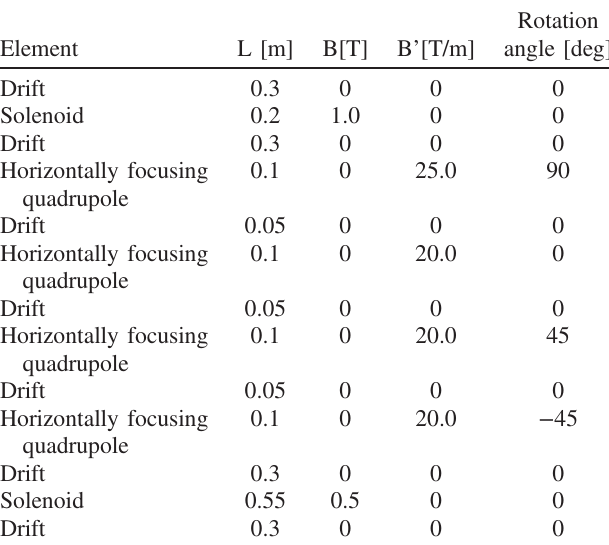
TABLE II. Beam line of the tracking calculations: element type, length, longitudinal magnetic field, magnet field gradient, and rotation angle around the positive beam axis.